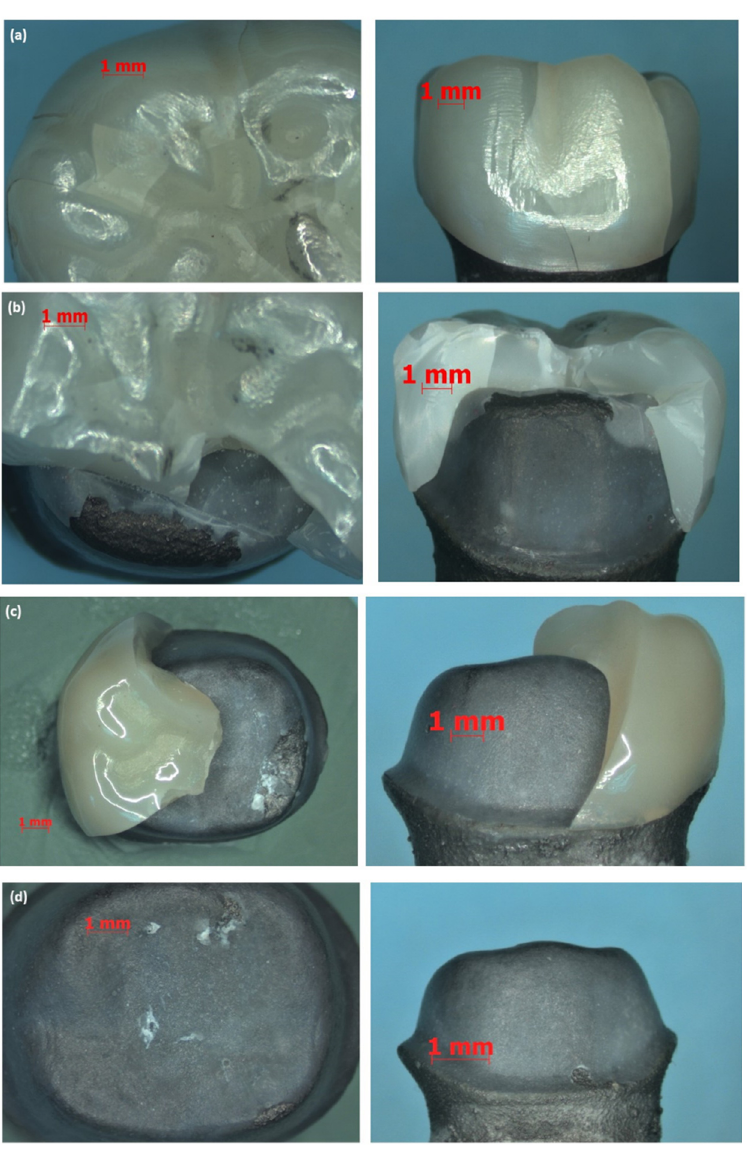
Figure 9. Stereomicroscopic analysis of different type of crown failures— occlusal and buccal views